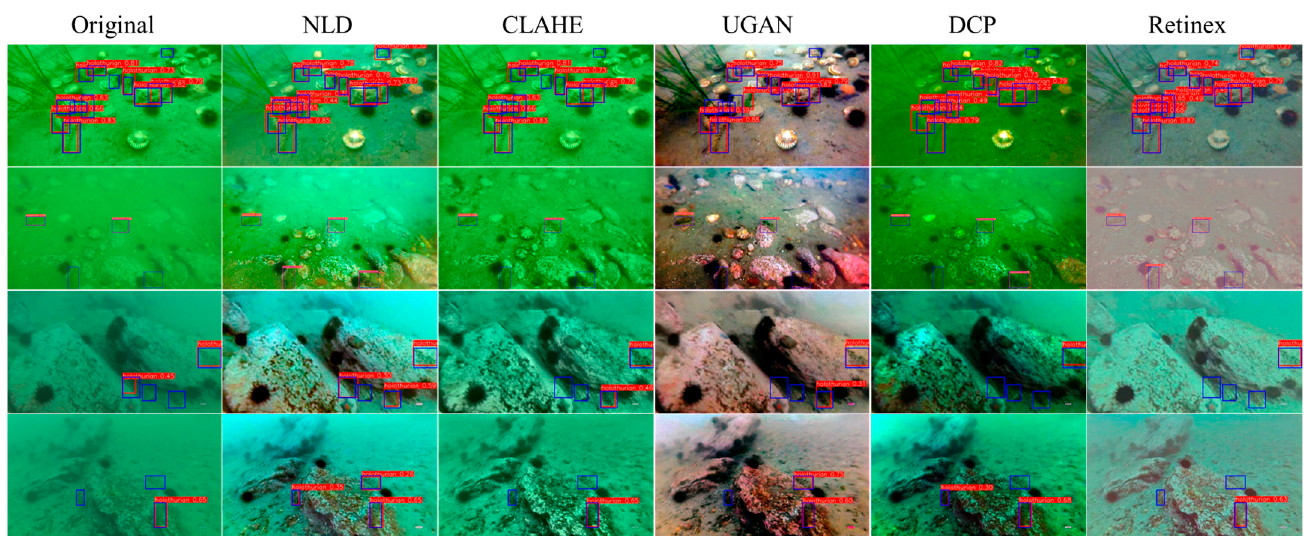
Figure 9. Examples of detection results by YOLOv7 with image enhancements.